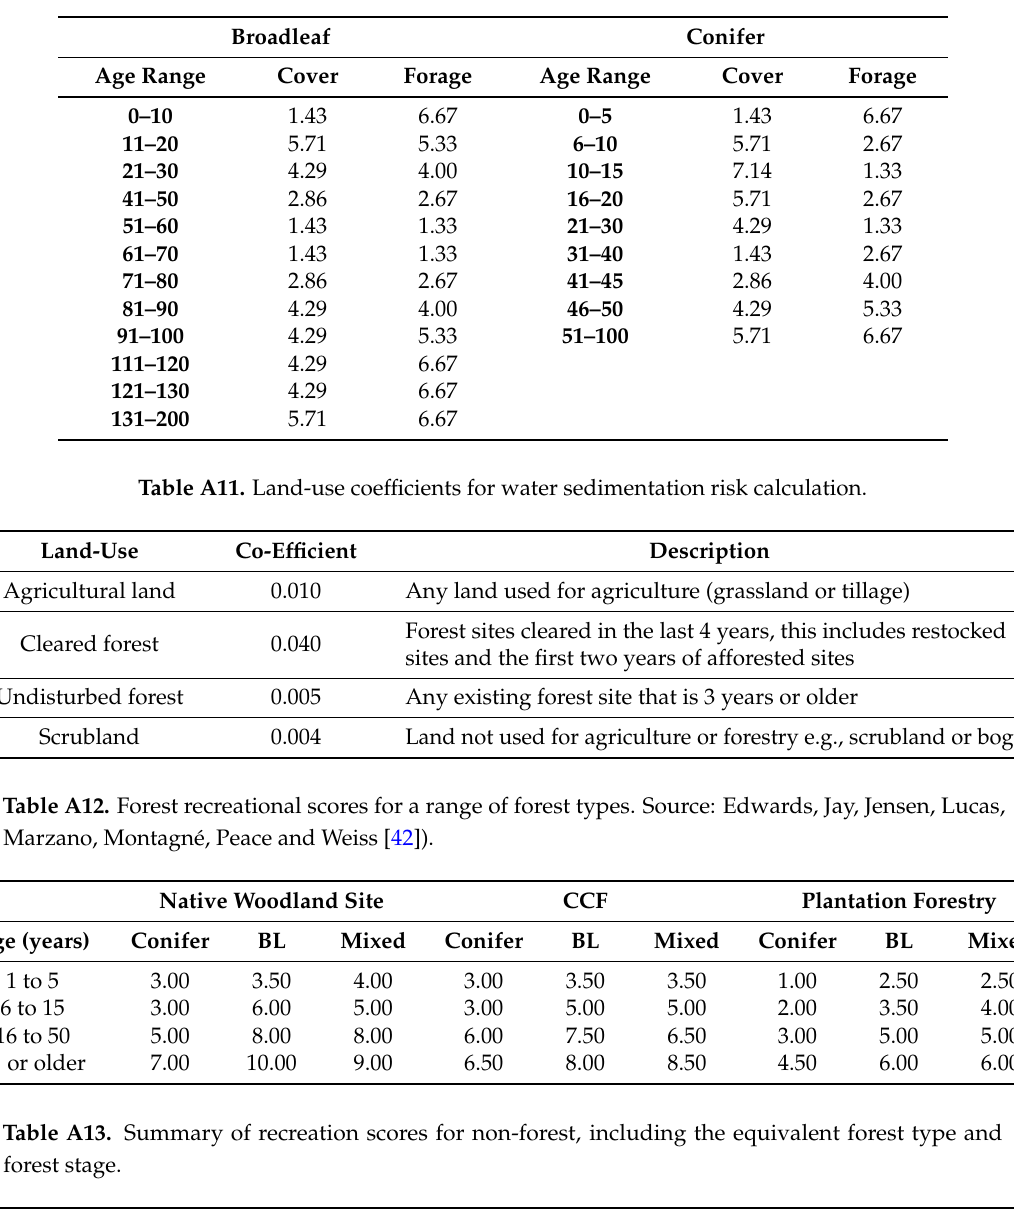
Table A10. Deer foraging and cover habitat suitability scores for broadleaf and conifer, by age classes (10 years for broadleaves, 5 years for conifers). Source: Barrett, et al. [60].